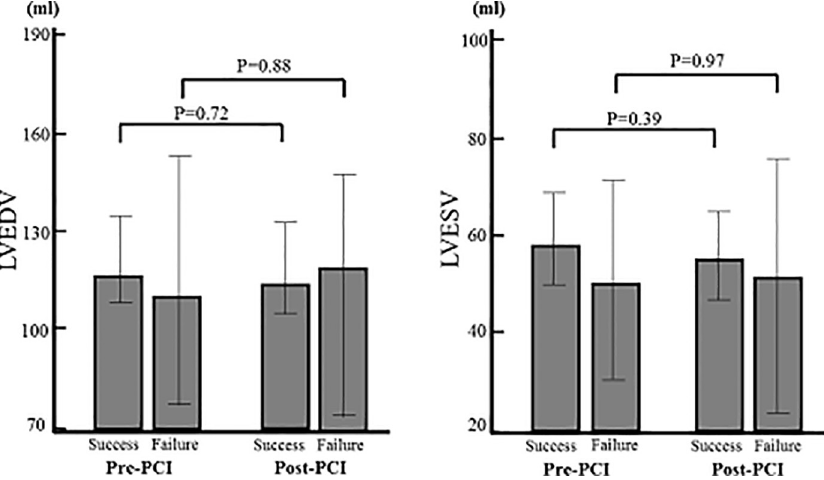
Fig 4. Change of LV volume from baseline to 9 months after PCI. LVEDV and LVESV showed no significant improvement in both successful and failed PCI